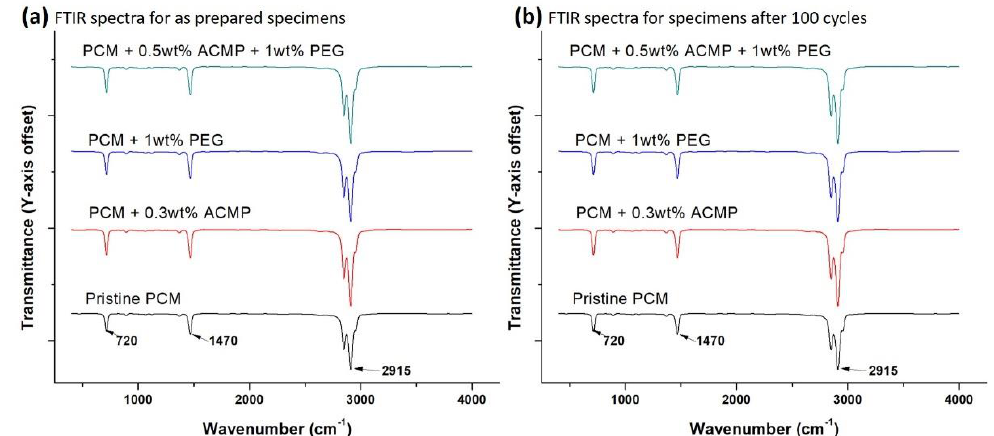
Figure 8. FTIR spectra of samples with optimum compositions ( a ) before and ( b ) after 100 consecutive thermal cycles.